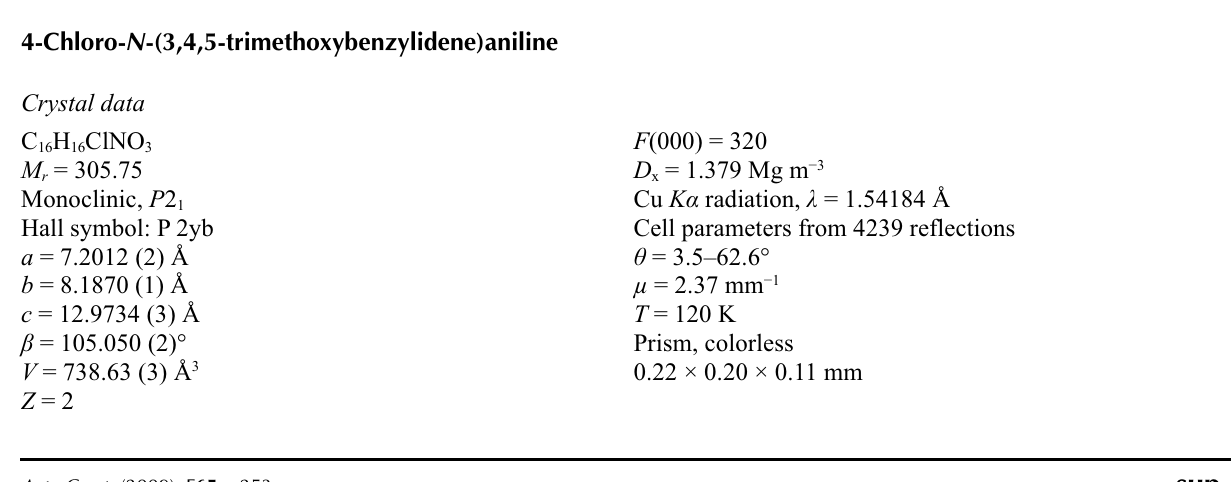
The packing of (I) viewed along a , with hydrogen bonds shown as dashed